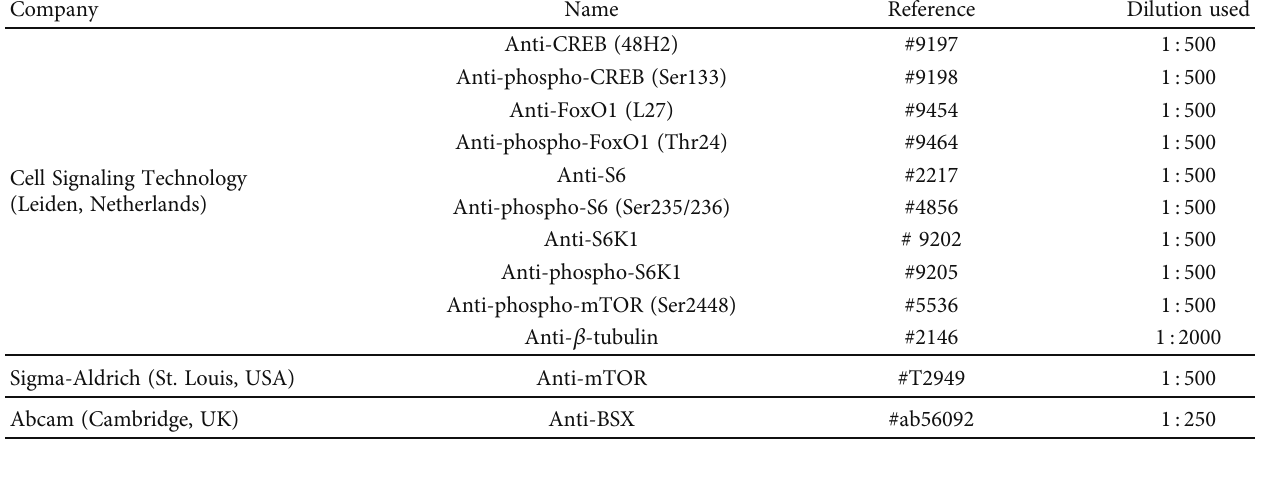
Table 2: Primary antibodies used to evaluate protein abundance by Western blot.